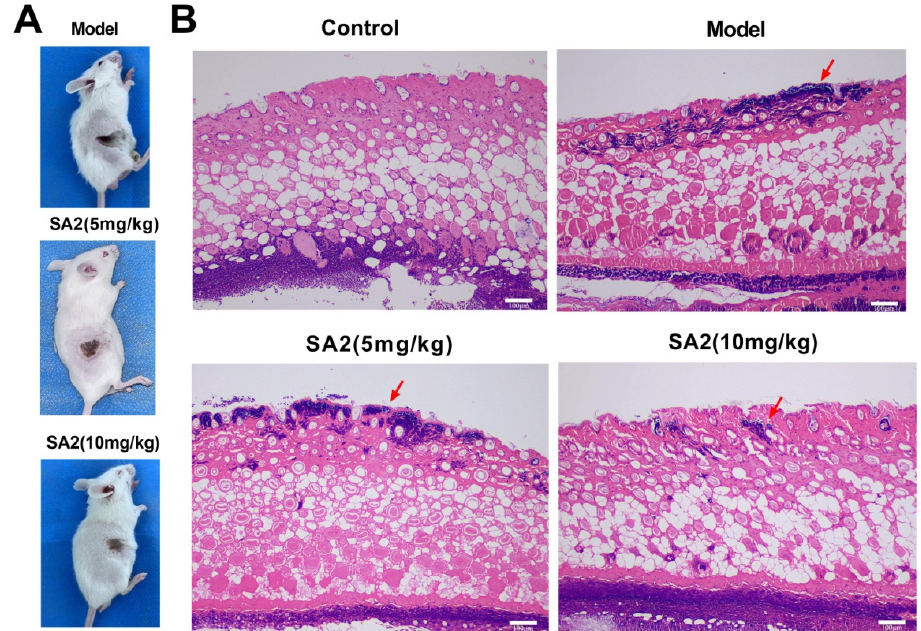
Figure 5. MRSA-induced skin infection was examined with H.E. staining in BALB/c mice. ( A ) The infective lesion size in the model control and intragastric administration of SA2 (5 mg/kg, 10 mg/kg) groups. ( B ) The pathological observation in the normal control, model control, and intragastric administration of SA2 (5 mg/kg, 10 mg/kg) groups. Arrows in red color indicate the inflammatory cells. Scale bar = 100 µm.